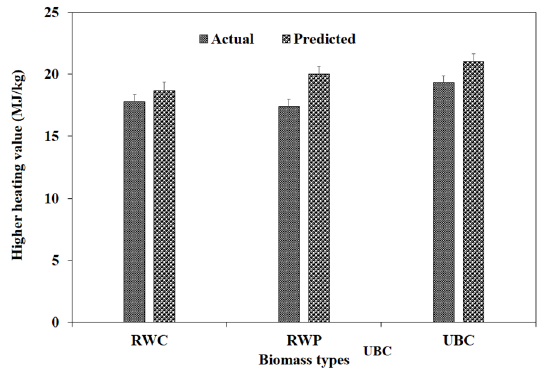
Fig. 4: Comparison of Estimated and Measured HHV, with Estimates based on Ultimate Analysis.